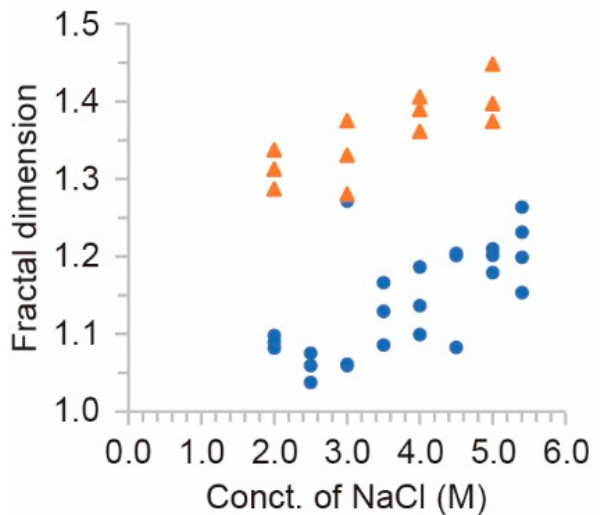
Figure 5. Fractal dimension of NaCl crystal. Blue circle are the results from flat source and orange triangles from point source.